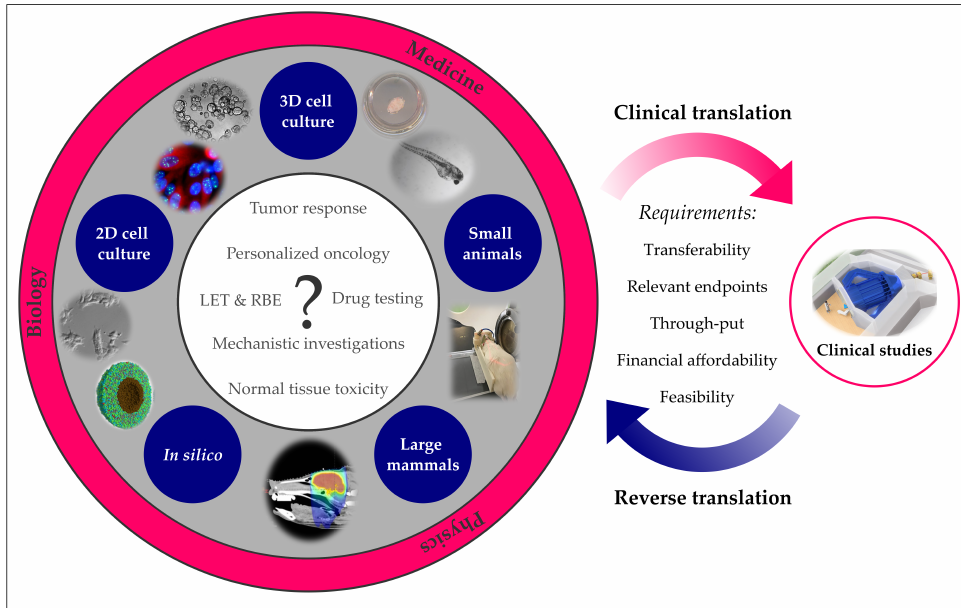
Figure 1. Translational research in (proton) radiobiology. Proton-specific research questions can be answered with a variety of preclinical models ranging from 2D cell culture to higher mammals. In silico approaches may deepen the understanding of underlying mechanisms. Preclinical insights can help to design clinical studies, and clinical observations can be back-translated into preclinical models. Images (clockwise): Tumor slice culture [39], irradiated zebrafish embryo [68], rat proton irradiation setup at Institut Curie [32], photon treatment plan of a mini-pig brain [69], simulated tumor spheroid 40 min post photon irradiation [70], migrating human uveal melanoma cells [22], fluorescence